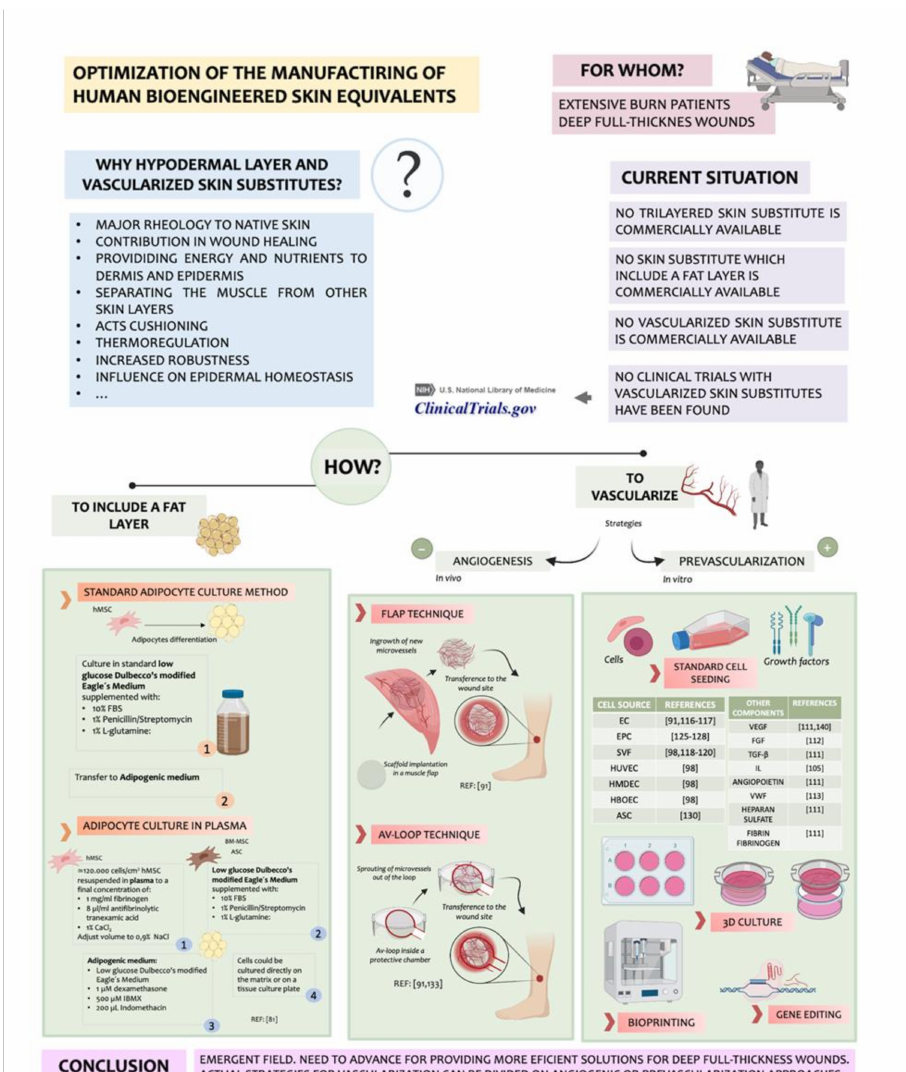
Figure 4. Synthetization of the strategies used for vascularizing skin